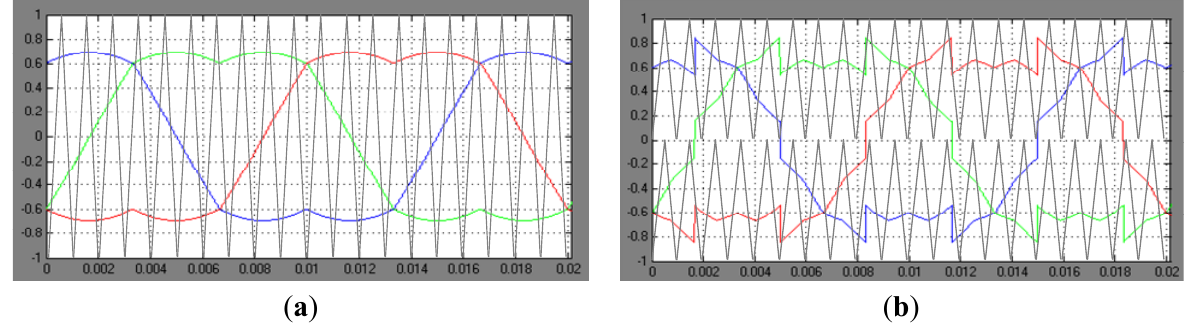
Figure 3. Example of modified modulating signals (normalized by V dc ) for optimized centered carrier-based PWM ( m = 0.8). ( a ) Single-2L inverter supplied by 2 V dc ; ( b ) dual-2L inverter (3L) supplied by V dc at each